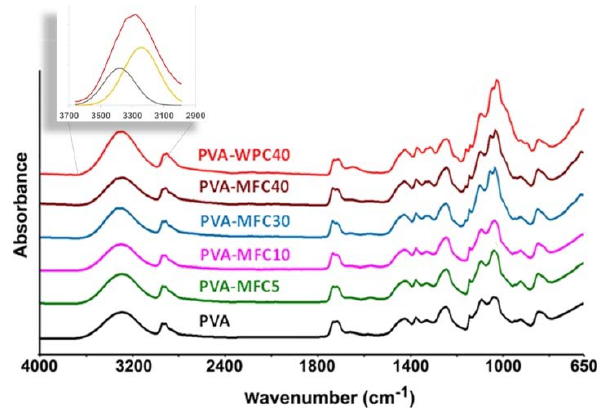
Figure 4. FTIR spectra of PVA, PVA-MFC and PVA-WPC foams. In the inset, an example of curve fit is reported.